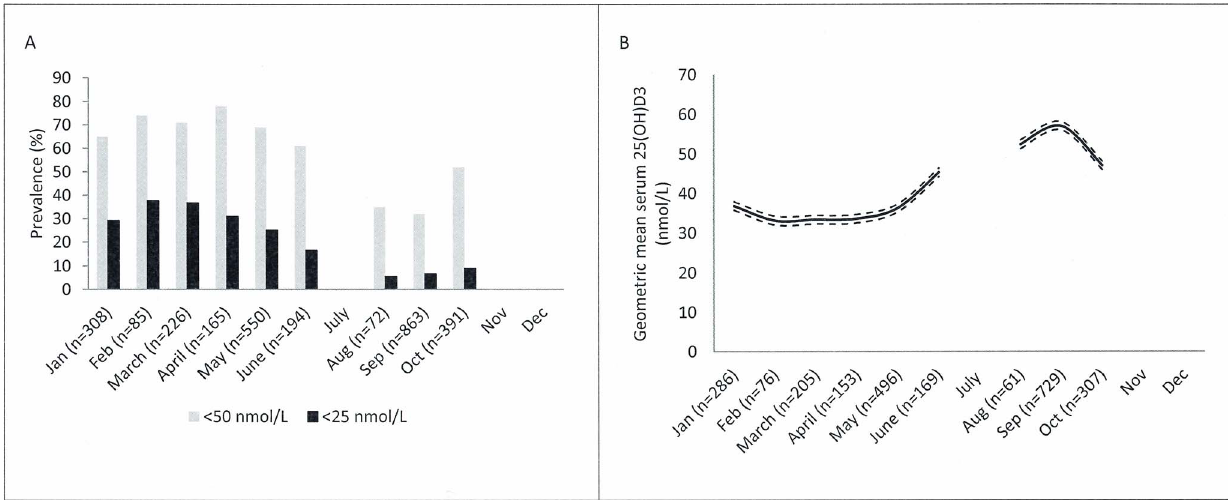
Figure 3. Seasonal variation in vitamin D. (A) Seasonal variation in vitamin D insufficiency ( , 50 nmol/L) and deficiency ( , 25 nmol/L) measured as serum 25(OH)D3 among 2854 adults included in the IHITstudy, 2005–2010, and (B) geometric mean serum 25(OH)D3 concentration (nmol/L) with 95% confidence interval by month after adjustment for age, gender and intake of traditional food among 2482 adults included in the IHIT study,